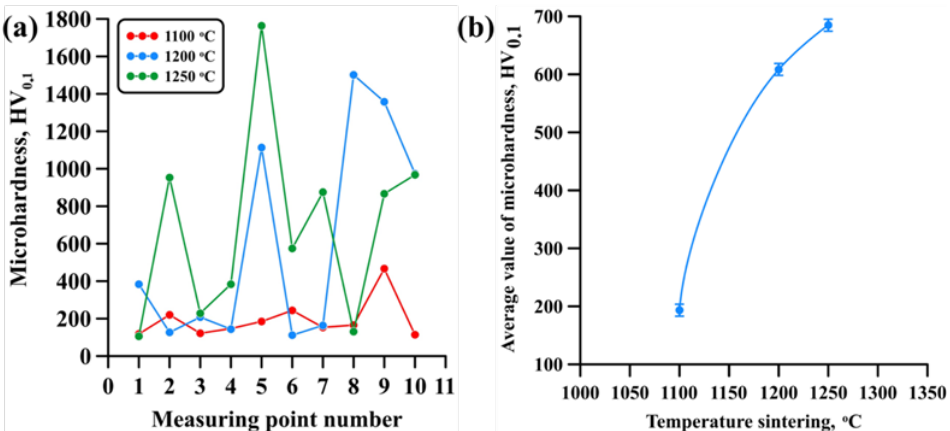
Figure 8. Graphical distribution of hardness in samples ( a ), dependency of sample hardness on the sintering temperature ( b ).